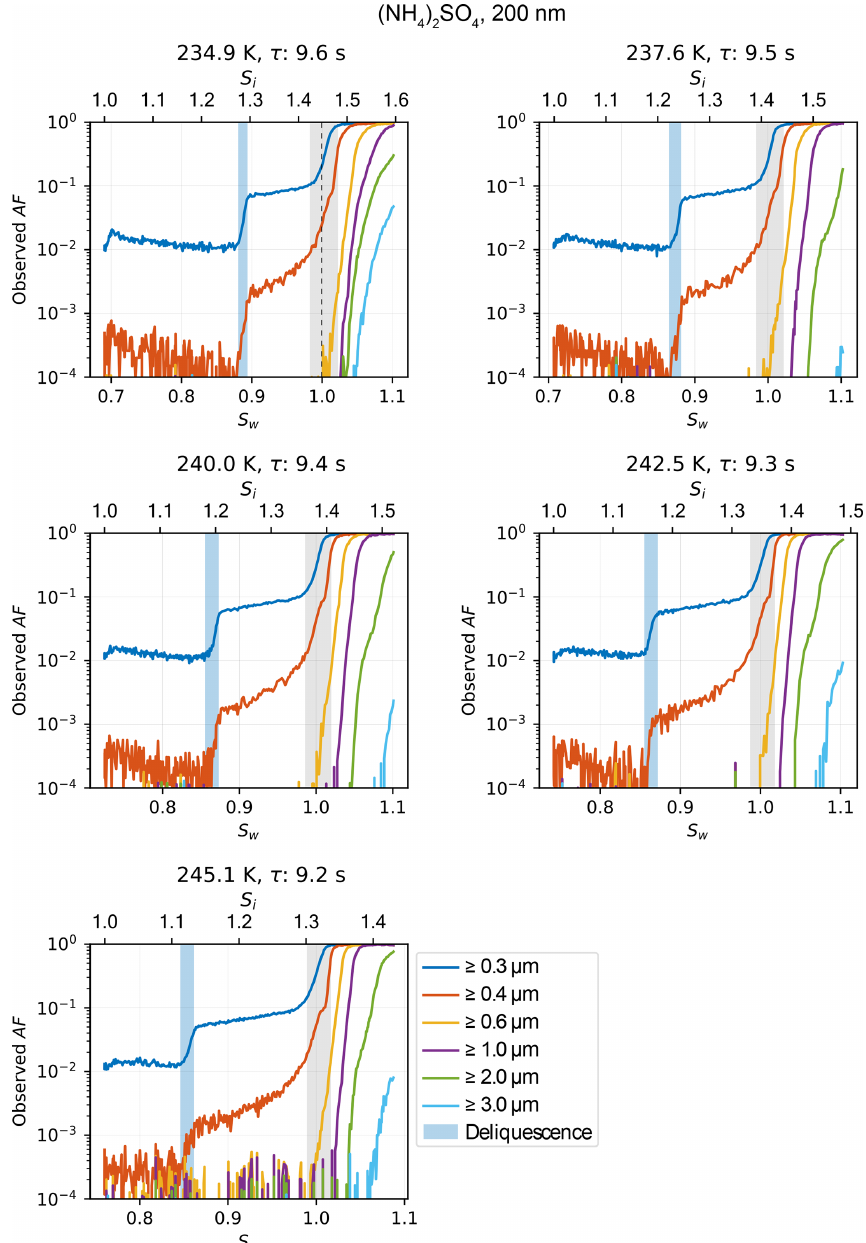
Figure A6. Relative humidity ramps showing the increase in AF during deliquescence and cloud droplet formation of 200nm ammonium sulfate particles at various temperatures. Light blue shading highlights the range of observed deliquescence; grey shading refers to chamber uncertainty (see Sect. 3.1 for